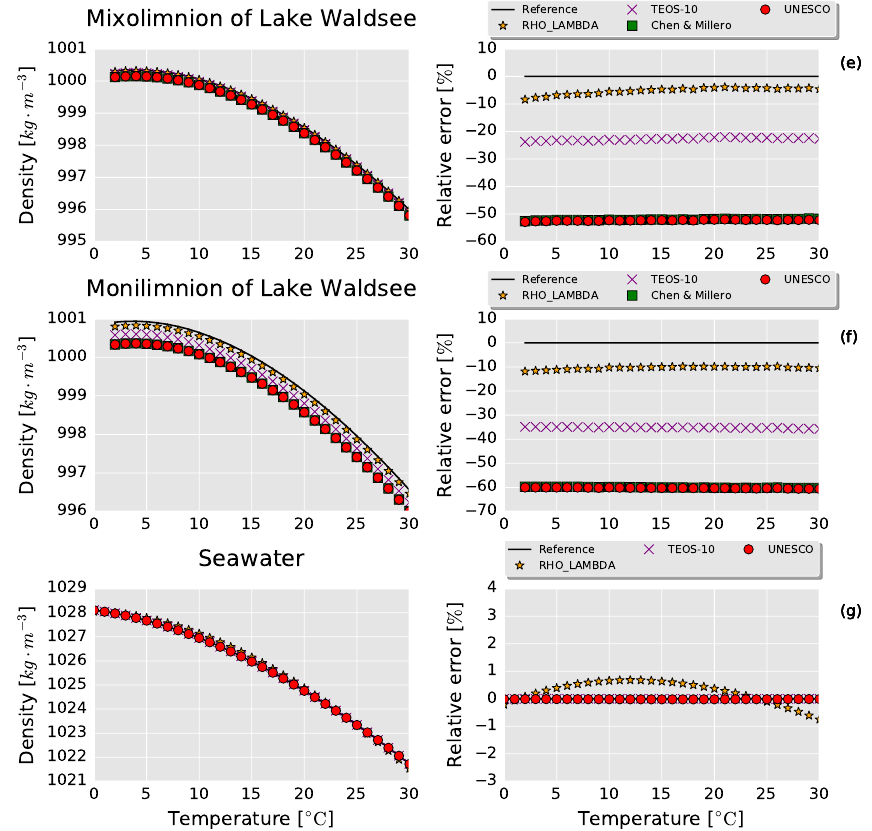
Figure 1. Test cases. The left panel presents the density curves of the different methods and the right panel shows the relative error of the density contribution of the solutes with respect to the reference. In all the cases, measured values have been used as a reference, except in the cases of Mono Lake (Jellison et al., 1999) and seawater (TEOS-10, IOC et al., 2010), which use specific density equations. (a) Rappbode Reservoir, (b) Lake Geneva, (c) Lake Constance, (d) Mono Lake. Continuation. (e) Mixolimnion of Waldsee, (f) Monimolimnion of Waldsee, (g) seawater.